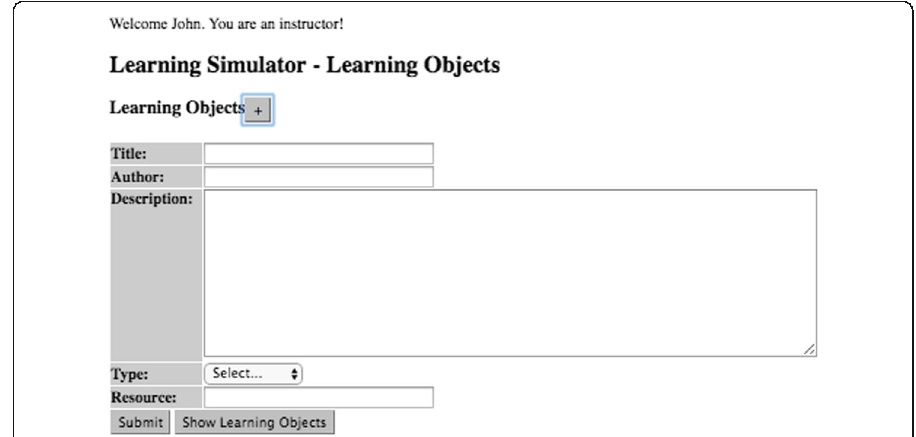
Fig. 2 LMS learning object creation (conforming to IMS-LD standard)